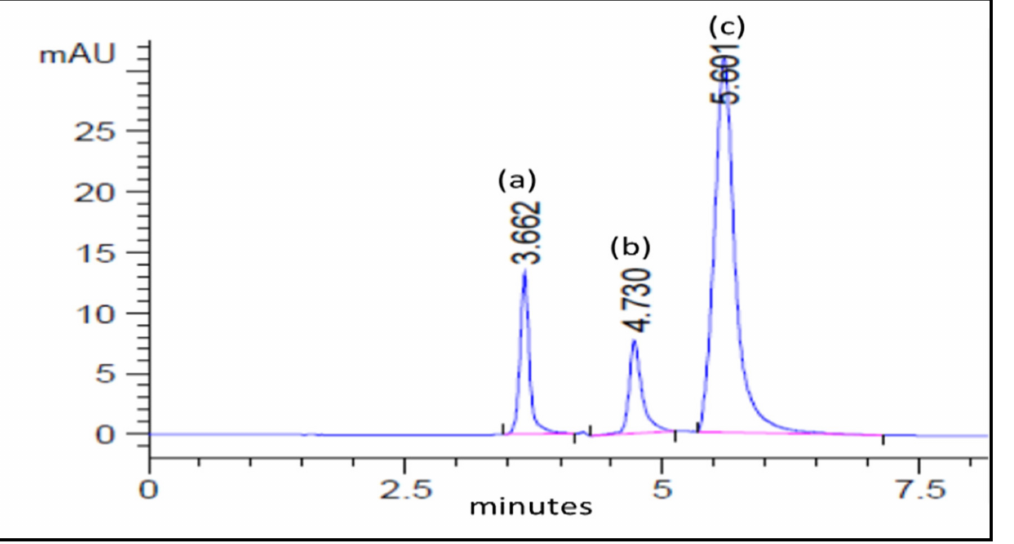
Figure 3. RP-HPLC chromatogram for the investigated mixture of ( a ) 40 µ g/mL timolol maleate (Rt 3.6) ( b ) 20 µ g/mL oxidative degradation product of timolol maleate (Rt 4.7) and ( c ) 60 µ g/mL brinzolamide (Rt 5.6) on a Eurospher C18 stationary system, with a mobile phase composed of triethylamine pH 3.5: acetonitrile (20:80, in